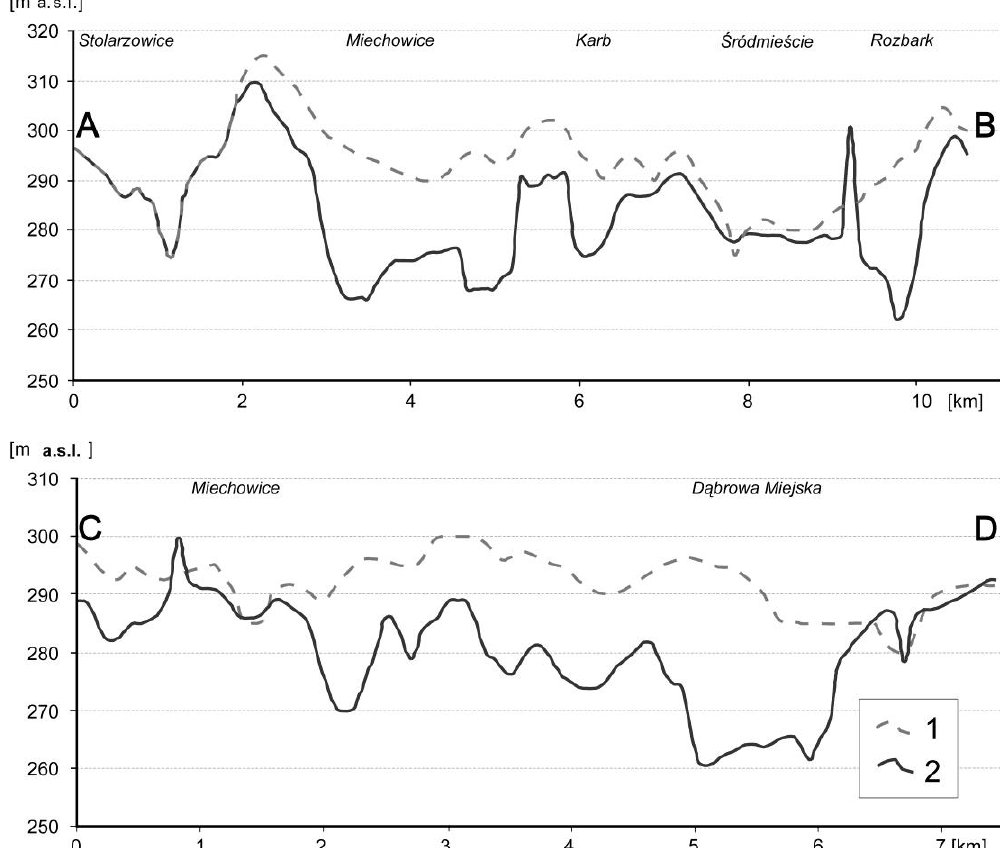
Fig. 3. Changes in the land relief profiles in Bytom in the period of 1883-1994 (the author’s own work) 1 – 1883, 2 –